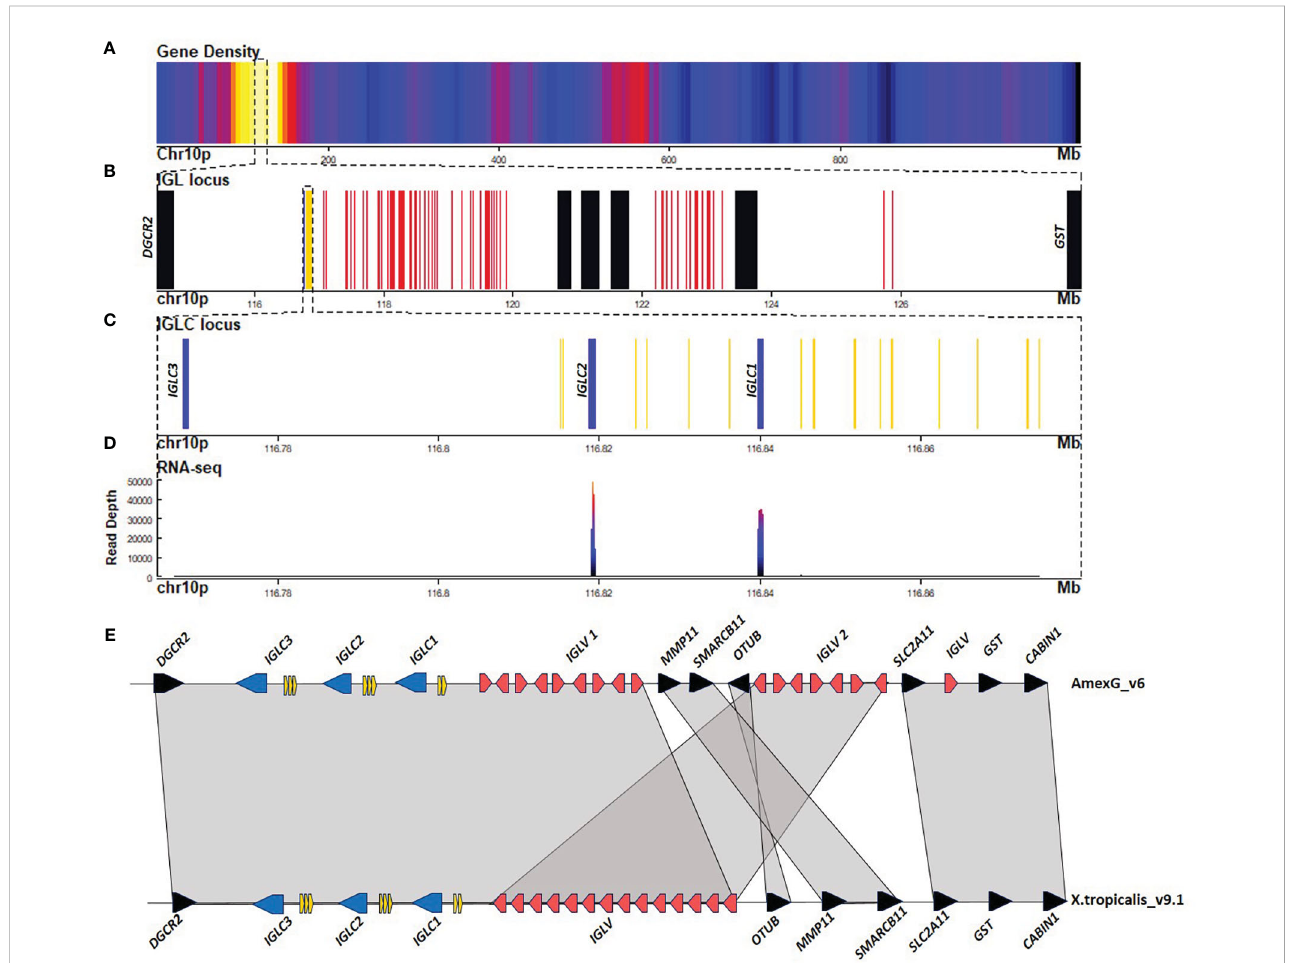
FIGURE 2 The lambda light chain locus is located in the centromeric portion of chr10p (116.7 - 125.8 Mbp). (A) Gene density plot of chr10p where the IGL locus is encoded (box). Dark blue colors indicate low gene density. (B) Zoom of the whole IGL locus (114.5-128.8 Mbp). Non-Ig genes (black) in proximal fl ank DGCR2 gene, and distal fl ank GST . Zoomed view of IGLC genes (blue), IGLV genes (red), and IGLJ (yellow). (C) Zoomed view (116.76-116.88 Mbp) of the IGHC gene cluster. (D) Spleen RNA-seq coverage histogram. Note that there is no expression in C l 3. (E) Schematic representation of immunoglobulin lambda locus in A. mexicanum genome (chr10p:116-124 Mbp) and X. tropicalis (chr1:144.7-144.9 Mbp). Color code as in A X. tropicalis displays the canonical architecture, in which the V, J, and C clusters are in the same orientation. Note that in A. mexicanum , IGLV genes are in at least two different clusters (IGLV1 and IGLV2), separated by the MMP11 , SMARCB11 , and OTUB genes, which in Xenopus are located in the distal fl ank. Also, note that the OTUB gene in axolotl is inverted. Moreover, as in the IGHV locus , IGLV segment orientation in axolotl is intercalated, which is atypical. VJ recombination involving the more distal IGLV segments would delete the OTUB , SMARCB11 , MMP11 , and the SLC2A11 gene cluster. Not on a